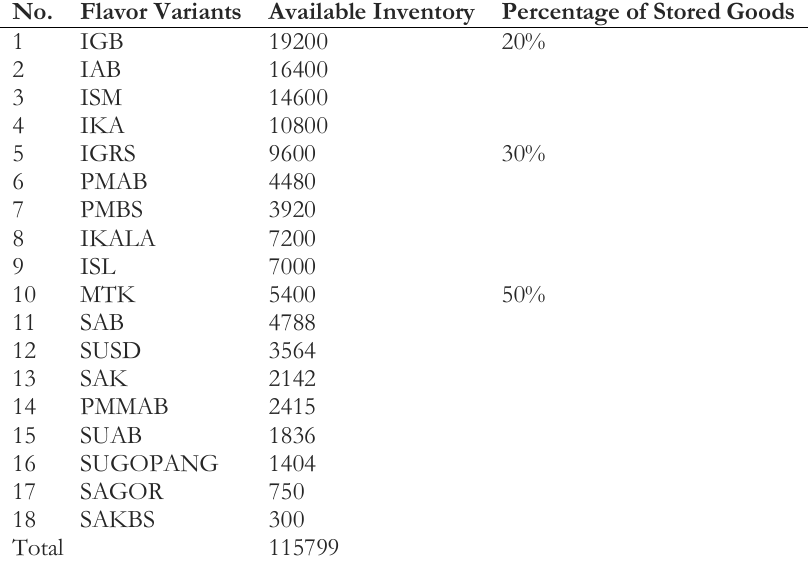
Table 1. ABC classification